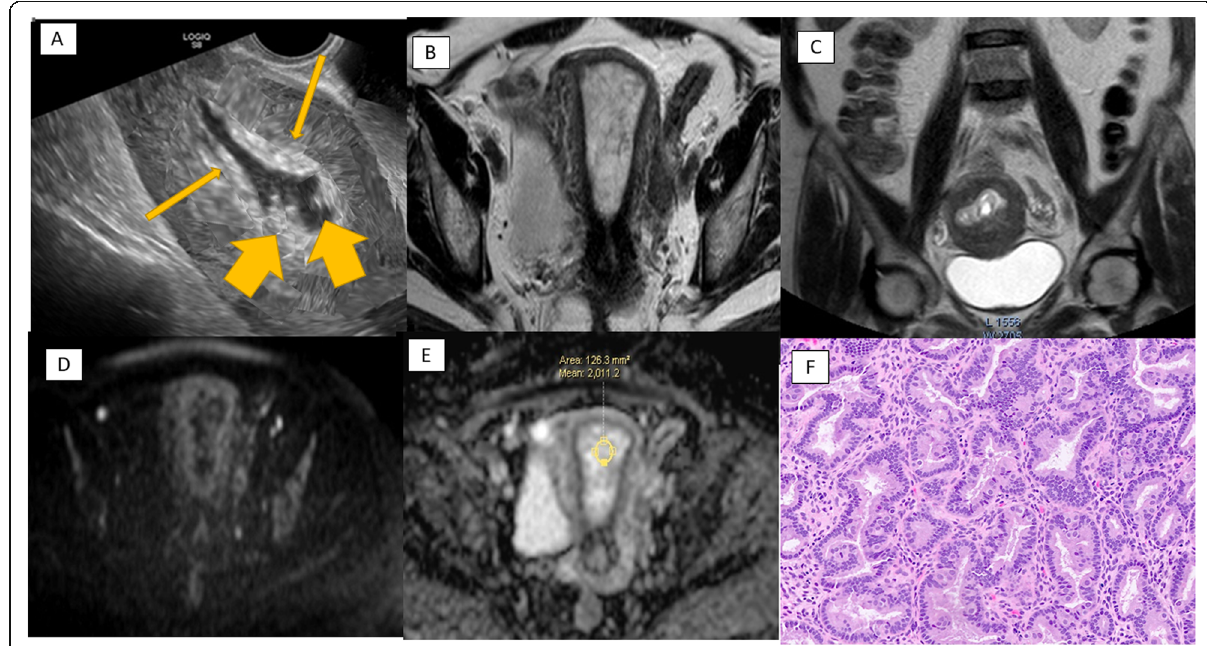
Fig. 1 Post-menopausal female aged 60 years old, presented with PMB. Sonohysterography image ( a ) showed diffuse thickened endometrium at the lateral uterine walls (long arrows) and focal thickening at the fundus (short arrows) which was considered suspicious for malignancy by both observers. Axial T2WI ( b ) and coronal T2 WI ( c ) showed diffusely thickened endometrium of hyper-intense signal and cystic areas, no infiltration of the junctional zone. DWI at b 1000 s/mm 2 ( d ) showed low signal intensity. ADC map ( e ) ADC value measures about ± 2.01 × 10 -3 mm 2